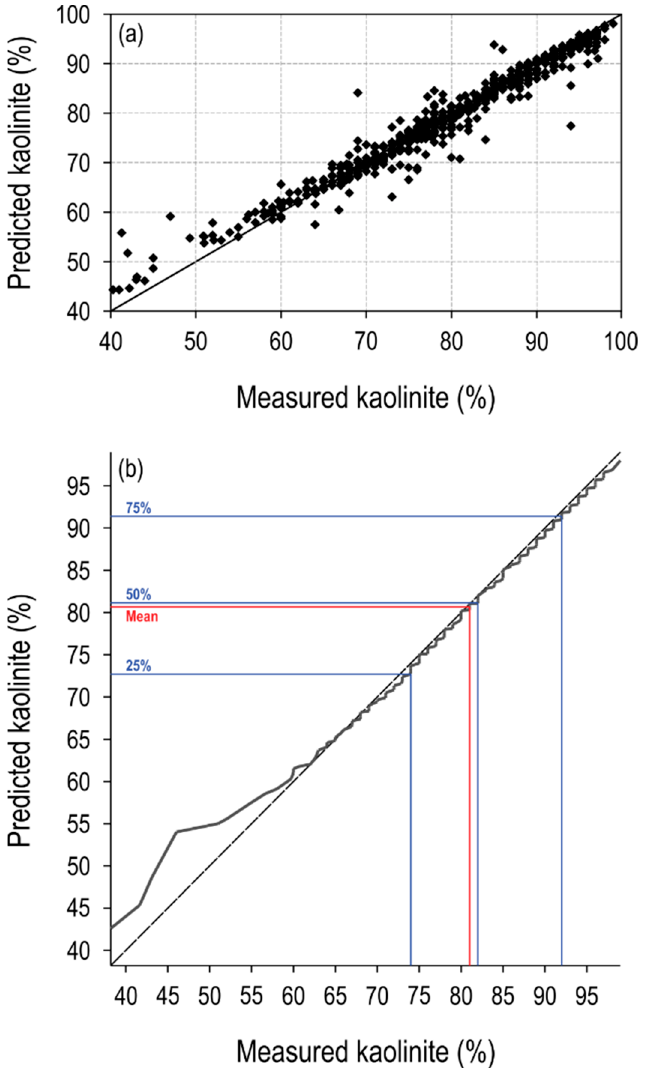
Figure 8. Kaolinite ML results (n = 699 samples); ( a ) measured kaolinite (XRD) vs. predicted kaolinite (ML) in weight percent; ( b ) as for ( a ) but for QQ plot.